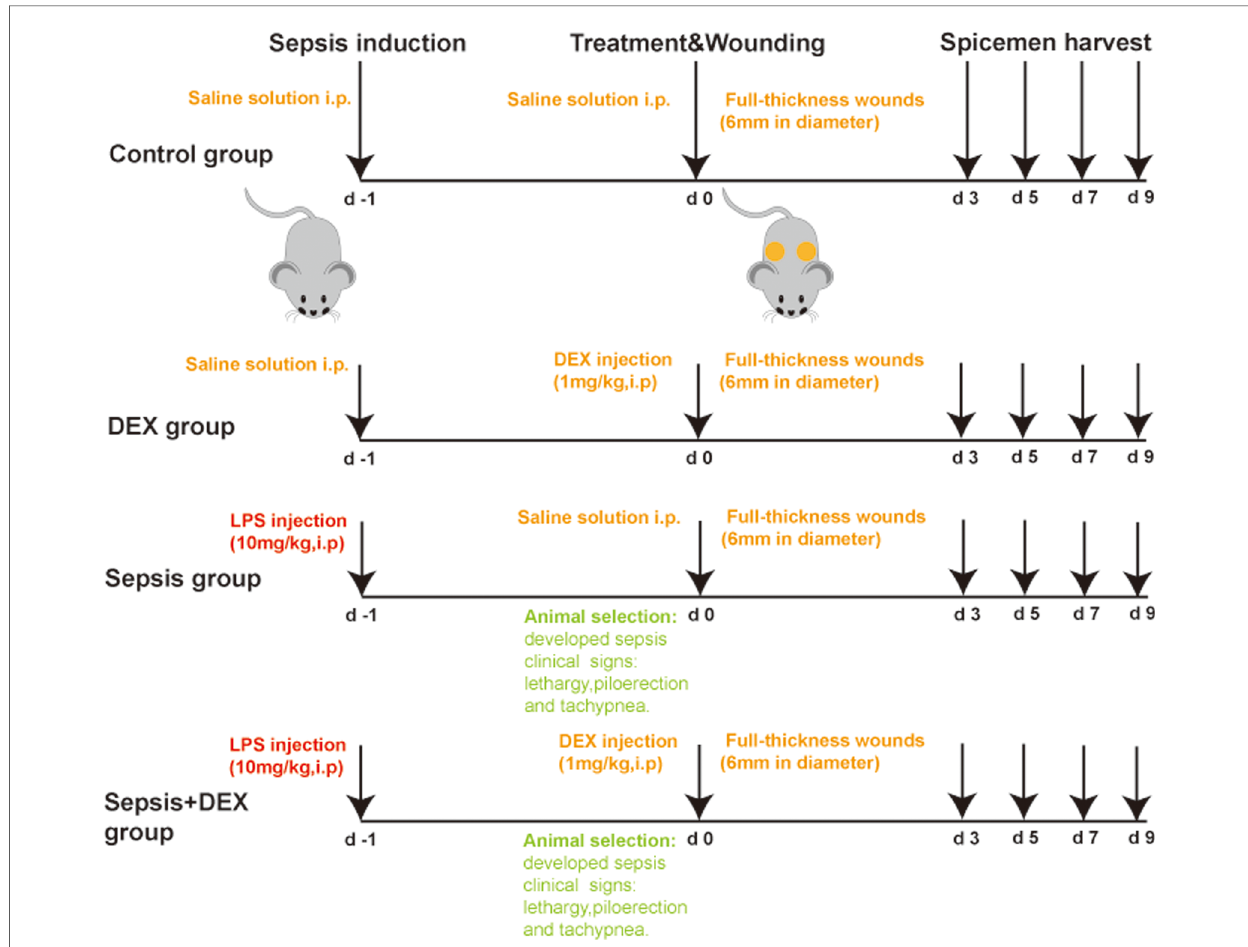
FIGURE 1 LPS sepsis model and medication procedure in the sepsis+DEX group. Medication procedure in 4